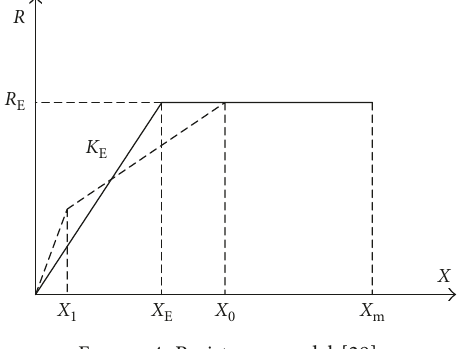
Figure 4: Resistance model [29].